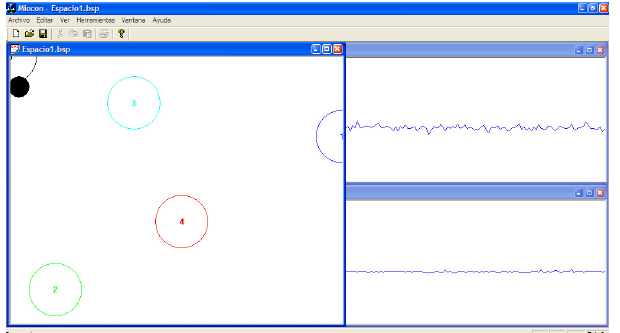
Figure 3. Target location on the state navigator tool: ’0’ (top left corner) is the rest state, ’1’ is the desired maximum voluntary contraction (DMVC) for the flexor carpi radialis, ’2’ is near the DMVC for the extensor carpi radialis, ’3’ is the desired medium contraction (DMC) for the flexor carpi radialis, and ’4’ is the DMC for a combination of flexor and extensor. Crosstalk can be noticed in ’1’, ’2’, and ’3’ as a deviation from the axes and simultaneous muscle activation in ’4’. The residual EMG activity slightly displaces the pointer downwards from the rest